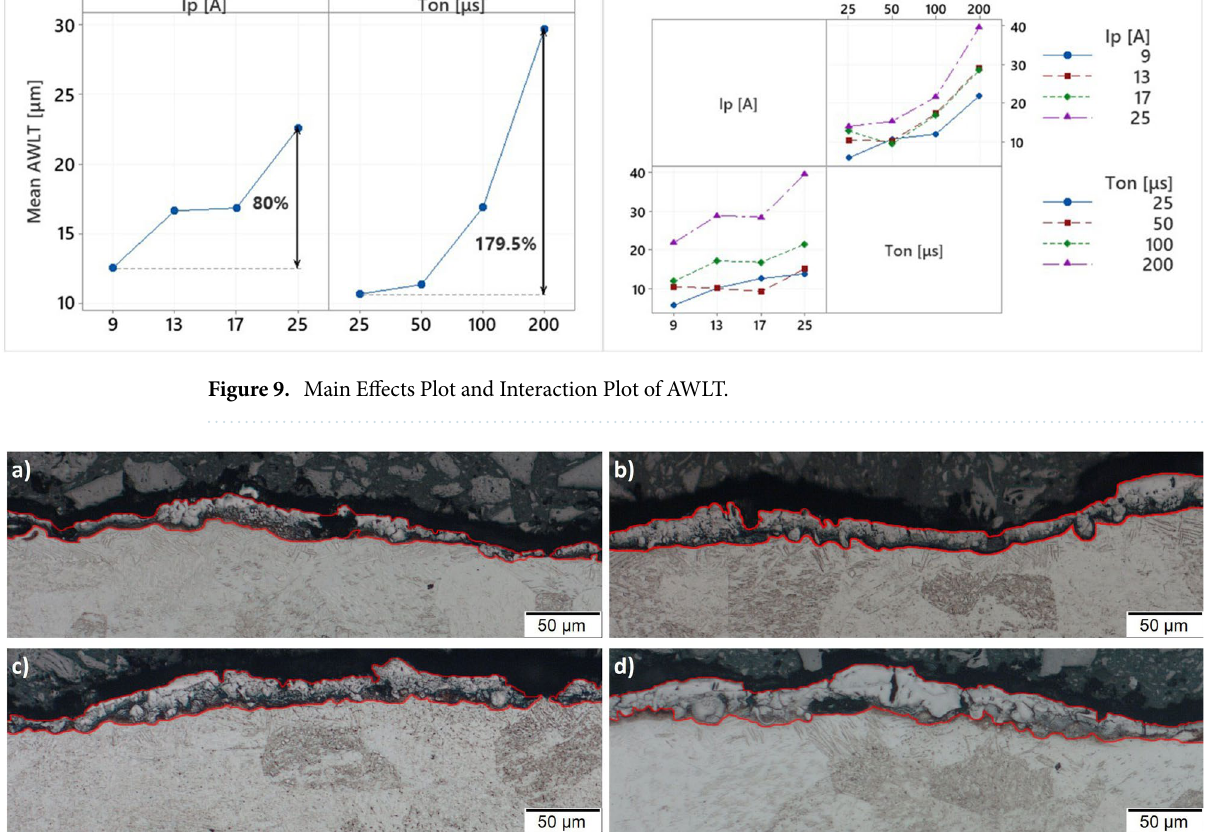
Figure 10. The WL for pulse-on current 17A and pulse-on times ( a ) 25 μs, ( b ) 50 μs, ( c ) 100 μs and ( d ) 200